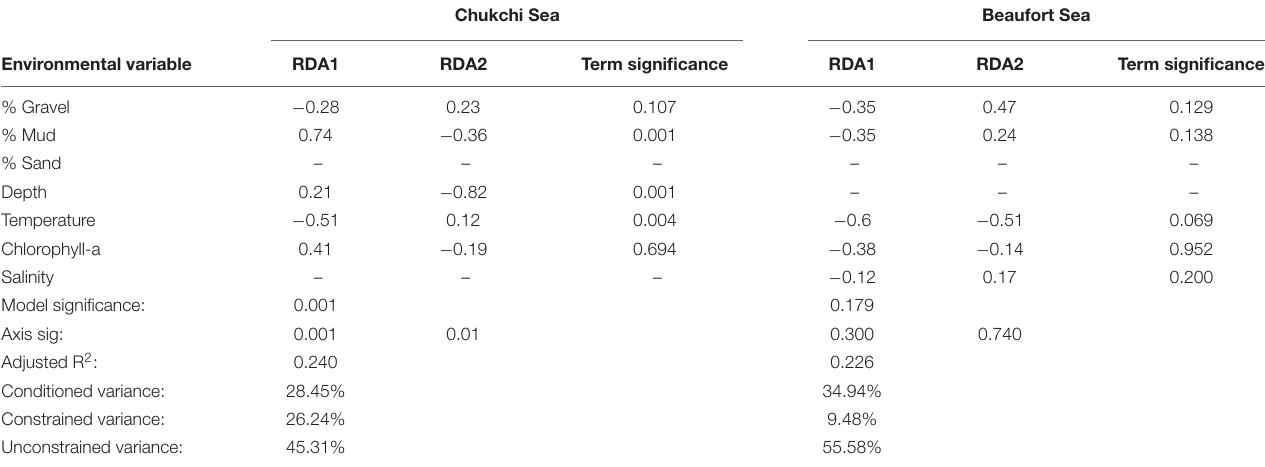
TABLE 3 | CWM-RDA outputs are shown as the loadings of environmental variables for the first two